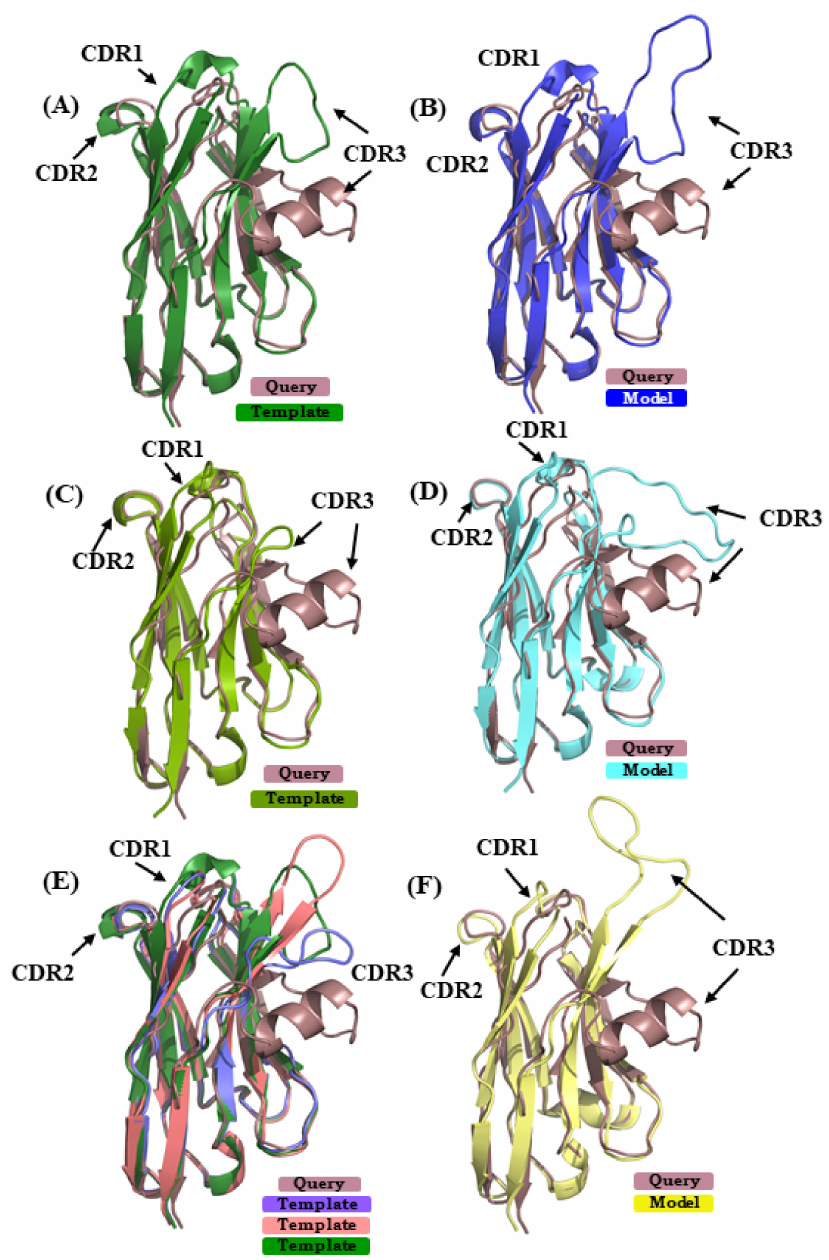
Figure 7. Superimposition of query structure V H H binding to phage Tuc2009 receptor binding protein (PDB ID 5E7B:A) with templates and models. The query structure V H H that was binding to phage Tuc2009 receptor binding protein (PDB ID 5E7B:A [34] is superimposed to different templates/models: ( A ), used in scenario 1 (PDB ID 1SJX:A [40]; ( B ) in scenario 2 (PDB ID 5H8D:A [41]); and ( C ) in addition to 1SJX:A, PDB ID 4ZG1:F [42], PDB ID 5JQH:C [43] are shown, respectively. ( B , D , F ) are the best-selected models using templates shown in ( A , C , E